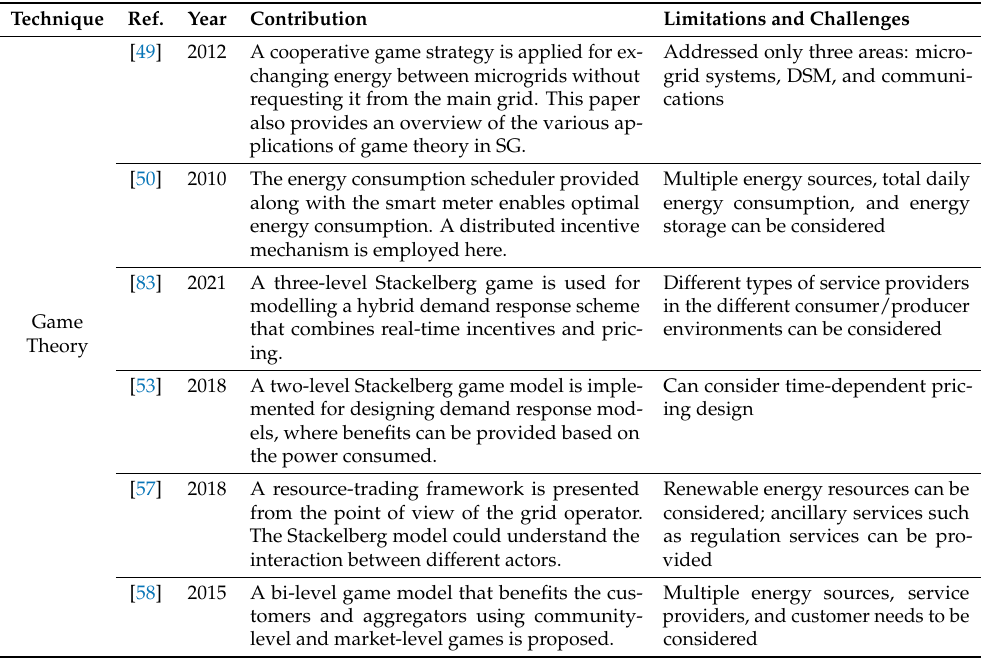
Table 3. Enabling technologies for designing incentive mechanisms in SG. Technique Ref. Year